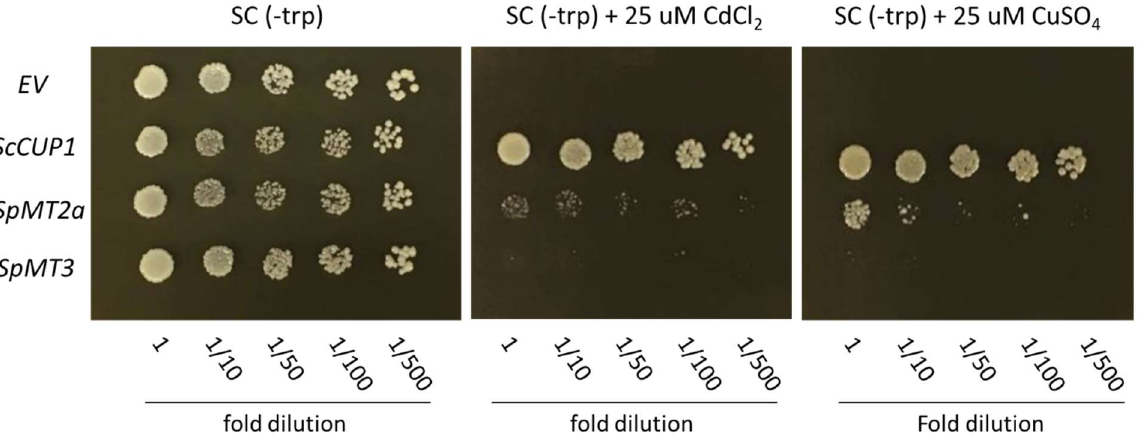
Figure 3. Transcript abundance of S. polyrhiza MT genes in whole plant tissues under metal stress: ( a ) SpMT2a . ( b ) SpMT3 . The S. polyrhiza plants were cultured in Hoagland solution supplemented with the indicated concentrations of CdCl 2 or CuSO 4 for 24 h. The relative transcript abundance was quantified and normalized to that of SpACT2 . The relative expression of the transcript abundance was adjusted to the control level. The asterisks indicate values that were significantly higher than the control condition and exceeded a fold change of two (one-tailed t -test, p < 0.05). The error bars represent SE (n = 3).